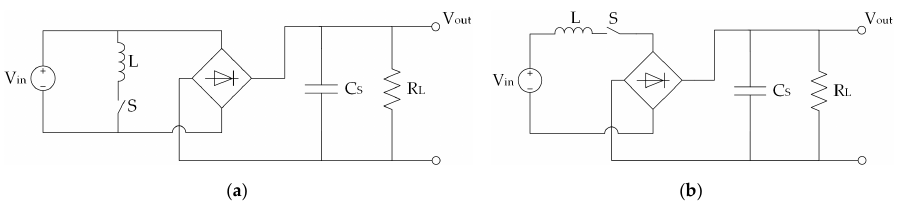
Figure 46. The S-SSHI ( a ) and the P-SSHI ( b )